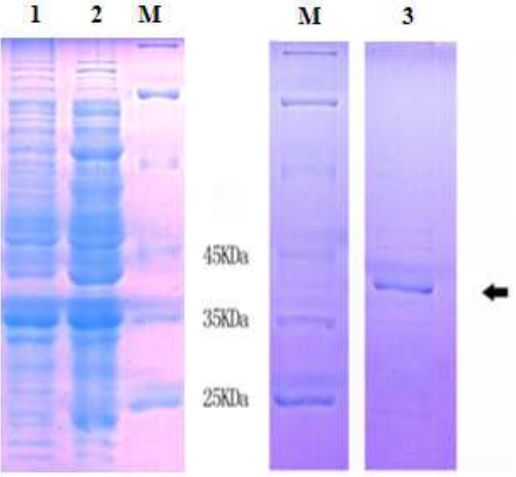
Figure 5. SDS-PAGE analysis of M. nipponense LDH protein purification. M, molecular mass standards; lane 1, Escherichia coli crude extract, without induction; lane 2, induced expression of recombinant MnLDH for 2 h; lane 3, purified protein as shown in black arrow.